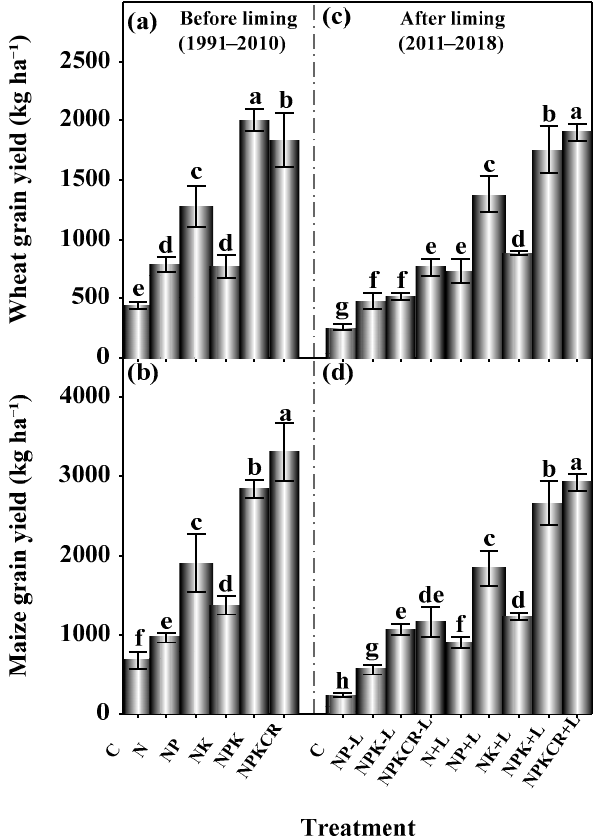
Figure 4. ( a ) Average annual wheat; and ( b ) maize grain yields, before liming; ( c ) annual wheat; and ( d ) maize grain yields, after liming, under various fertilization treatments of a field experiment in a wheat-maize rotation. Bars represent SD of means ( n = 4). Bars with different letters indicate a significant difference at p ≤ 0.05 by the LSD test. C: no fertilizer application or control, N: nitrogen, NP: N and phosphorus (P), NK: N and potassium (K), NPK: N, P, and K, NPKCR: NPK plus crop residue (CR), − L: without lime application, +L: with lime application.